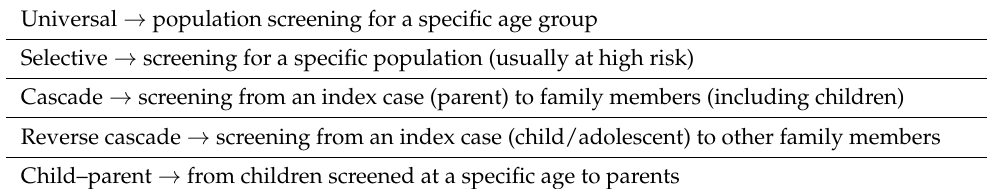
Table 1. Different screening methods to detect FH in children and